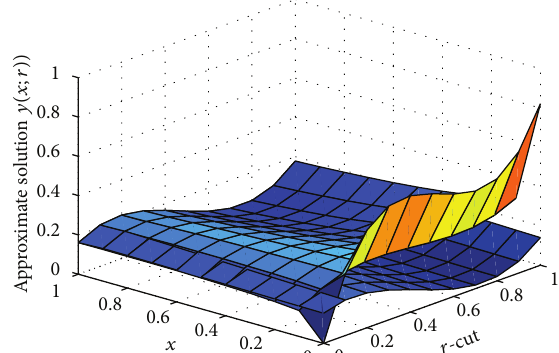
Figure 19: The absolute error for different 𝑚 of Example 63, 𝛼 = 0.95 .